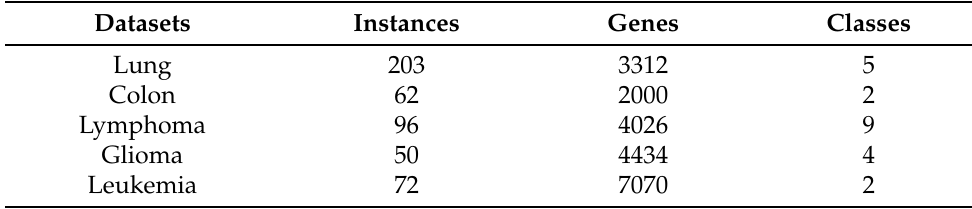
Table 1. Details of the datasets.